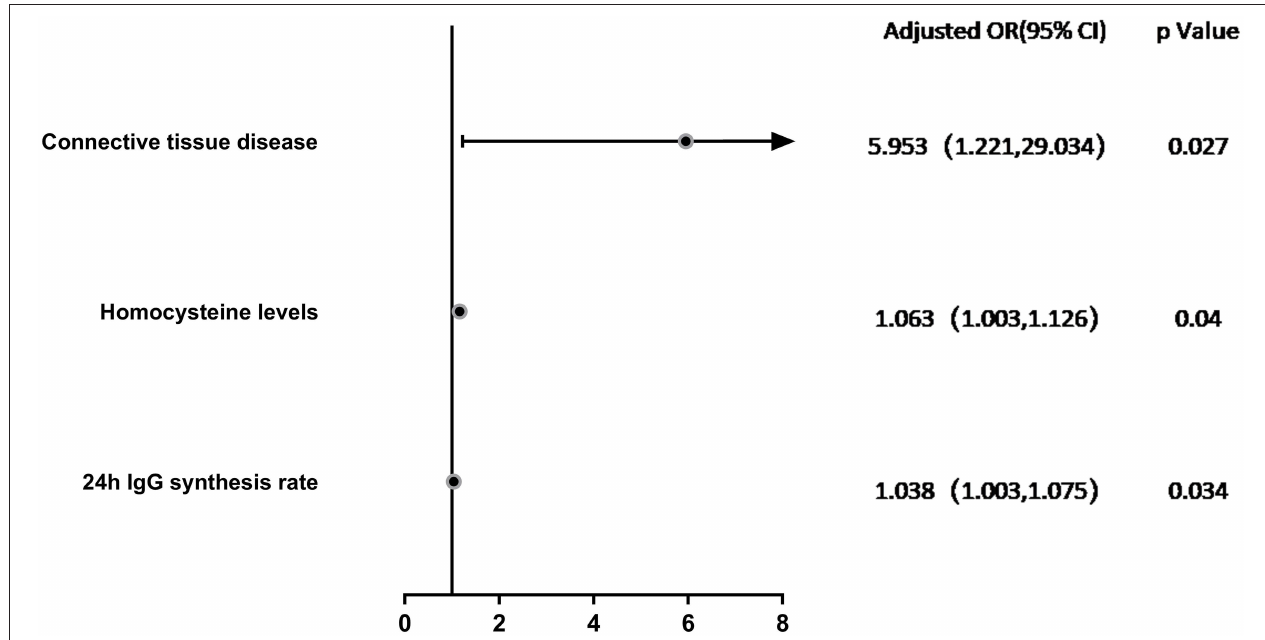
FIGURE 3 | Forest Plot. Multivariate logistic regression analysis of factors associated with highly active NMOSD in Adjust I model. Connective tissue disease (OR = 5.953, 95% CI: 1.221–29.034, P = 0.027), Hcy levels (OR = 1.063, 95% CI: 1.003–1.126, P = 0.04), and 24h IgG synthesis rate (OR = 1.038, 95%